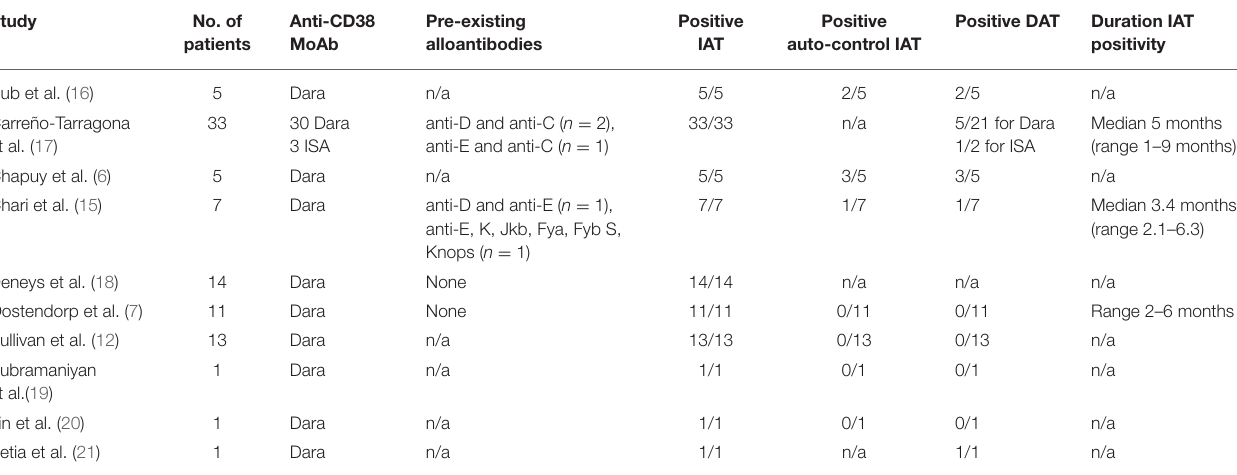
TABLE 1 | Clinical data on anti-CD38 monoclonal antibody interference with blood bank testing.